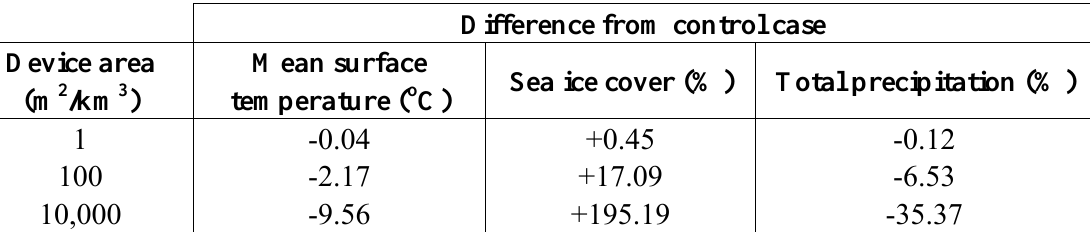
Table 1. Differences between the values of global-average parameters from climate runs with high-altitude devices for increasing device areas throughout the entire atmosphere and those from the control case with no such devices. A uniform device density of 1 m 2 /km 3 corresponds roughly to the world’s electricity demand.